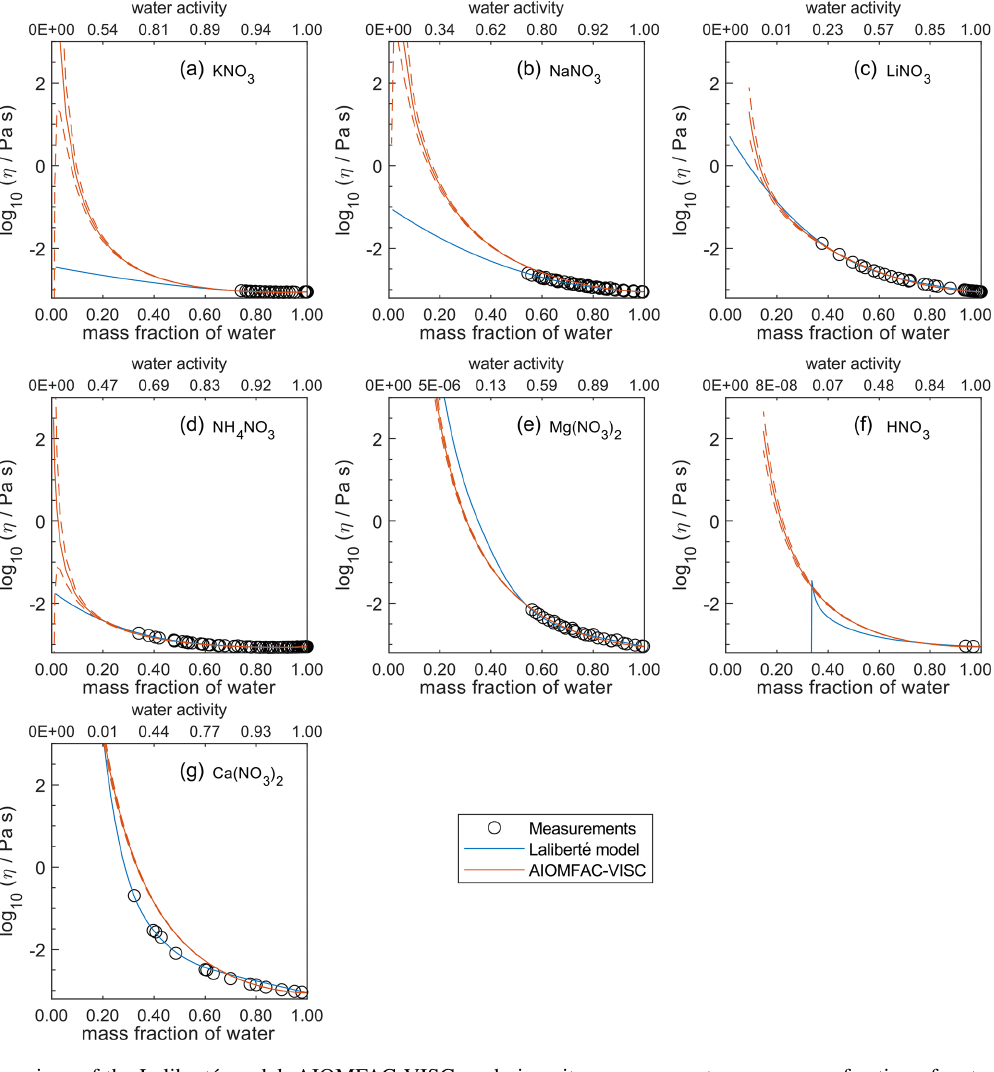
Figure 6. Comparison of the Laliberté model, AIOMFAC-VISC, and viscosity measurements versus mass fraction of water (bottom axis) and AIOMFAC-predicted water activity (top axis) for binary solutions of nitrate salts at 298K with bulk measurements shown for 298 ± 1K: (a) KNO 3 , (b) NaNO 3 , (c) LiNO 3 , (d) NH 4 NO 3 , (e) Mg(NO 3 ) 2 , (f) HNO 3 , and (g) Ca(NO 3 ) 2 . See Fig. 9 for comparison between bulk and droplet-based measurements for Ca(NO 3 ) 2 , Mg(NO 3 ) 2 , and NaNO 3 . See Fig. S8 for a zoomed-in version of this figure. See also caption